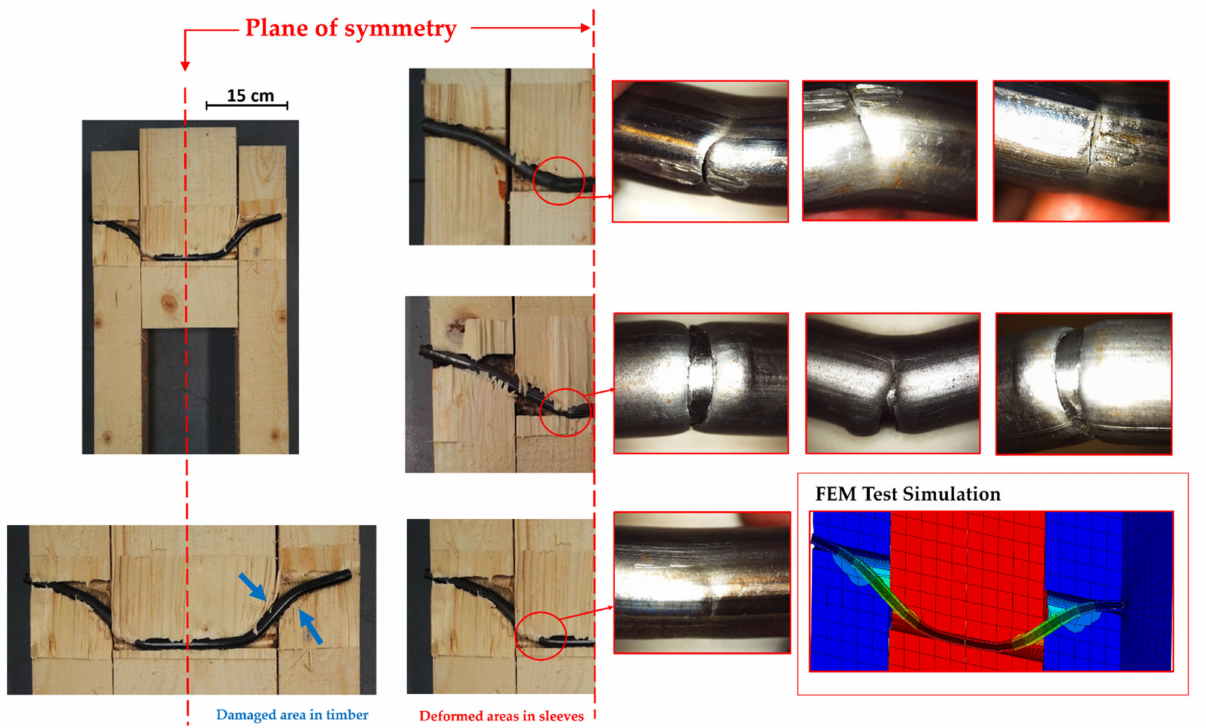
Figure 15. Deformed central section of the joint after the test ( left ) and details of the sleeve failures ( right